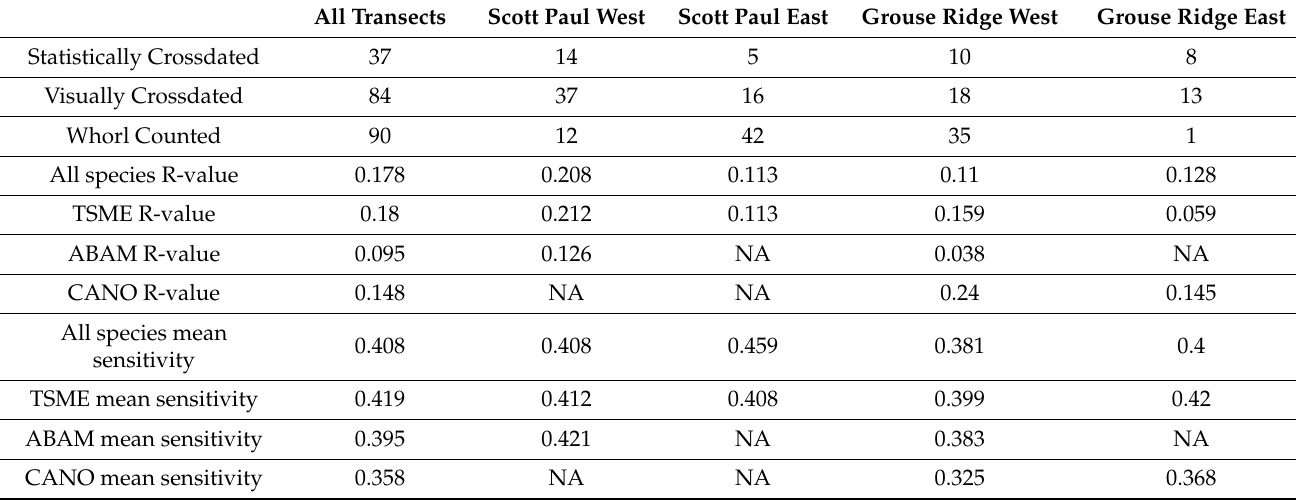
Table 5. The number of samples dated by each dating method, mean interseries ring-width correlations, and mean sensitivity of ring-width indices for each species at each transect, all species combined at each transect, and each species at all transects combined. Species include Tsuga mertensiana (TSME), Abies amabilis (ABAM), and Callitropsis nootkatensis (CANO). All Transects Scott Paul West Scott Paul East Grouse Ridge West Grouse Ridge